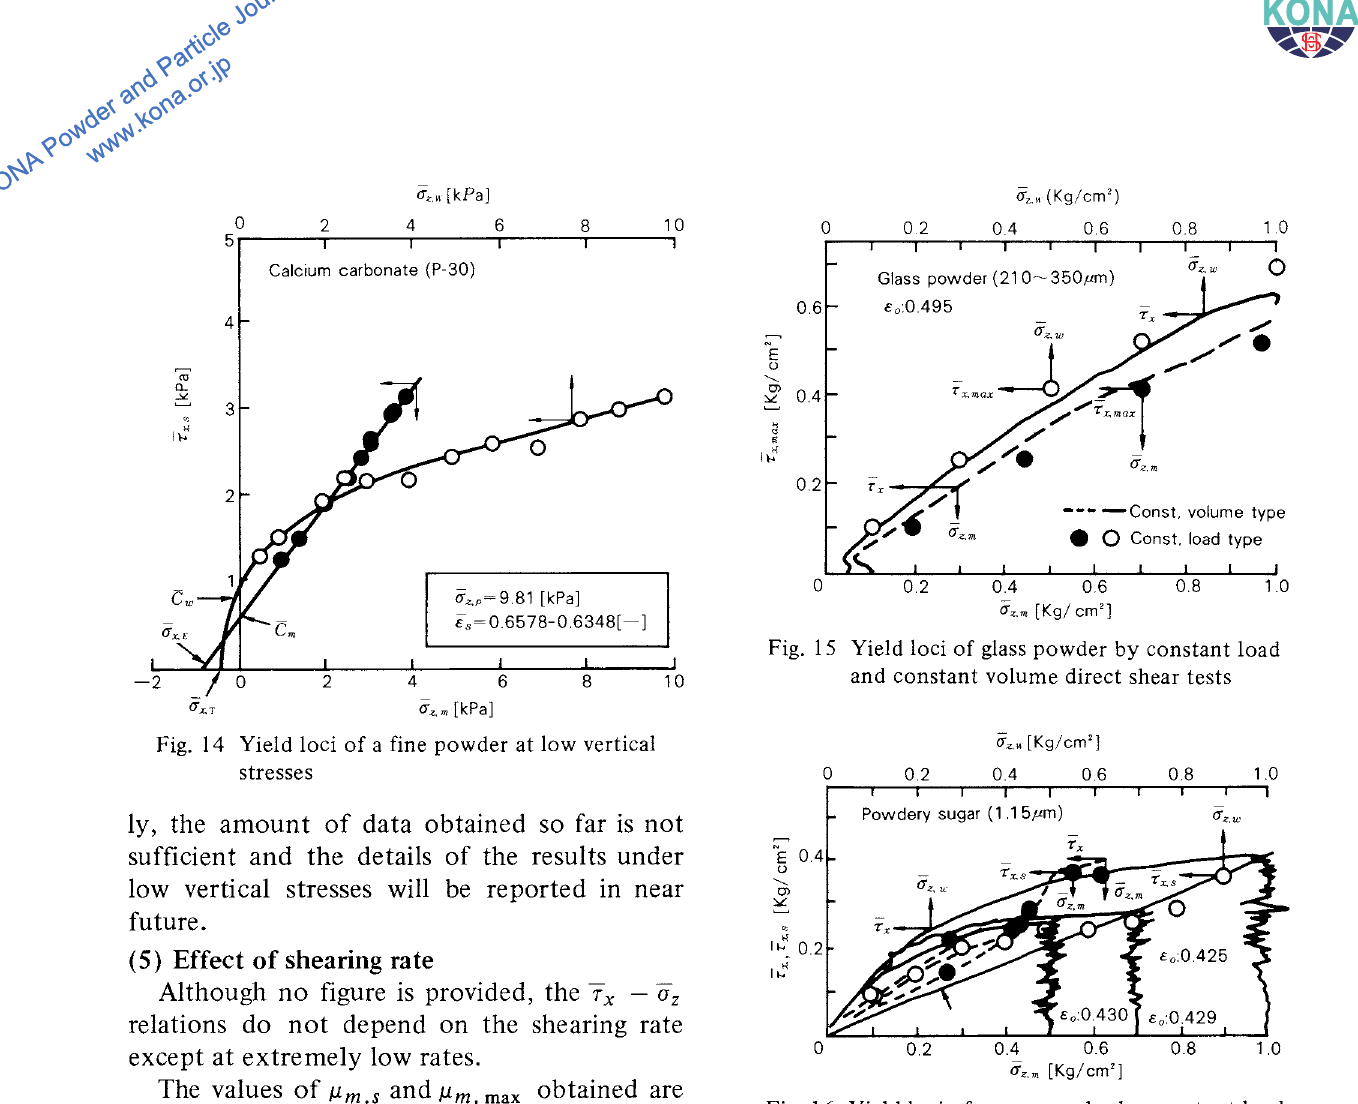
Fig. 16 Yield loci of sugar powder by constant load and constant volume direct shear tests.